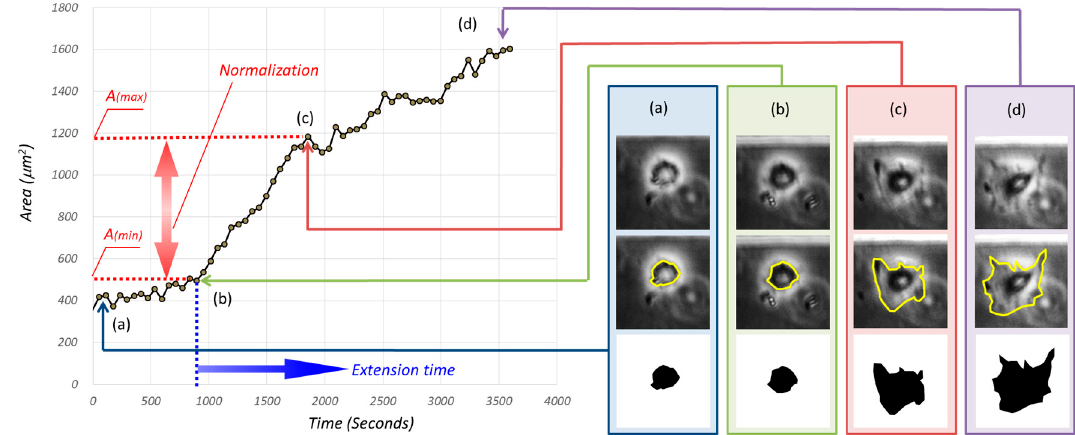
Figure 6. An example of the projected cell area with respect to time. ( a , b ) are the cell images at different instance, and from the top to the bottom are the original cell image, contour extraction, the projected cell area, respectively. It should be noted that the increase velocity of the projected cell area from (b) to ( c ) is larger than that of other phases, such as from (c) to ( d ). For determining point (b) and point (c), we used S( t ), defined by: